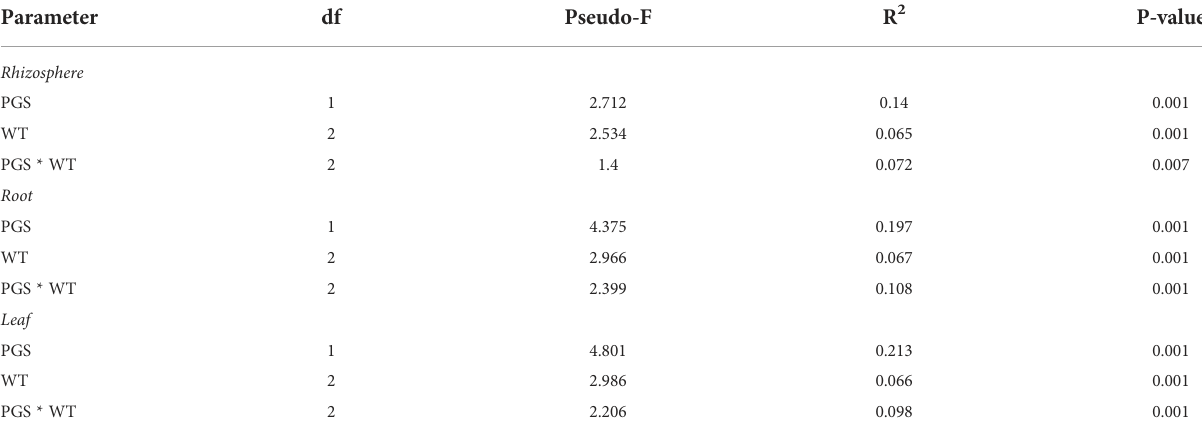
TABLE 2 The effect of plant growth stage (PGS) and watering treatment (WT) on the fungal community structure associated with the rhizosphere, root and leaf compartments. Parameter